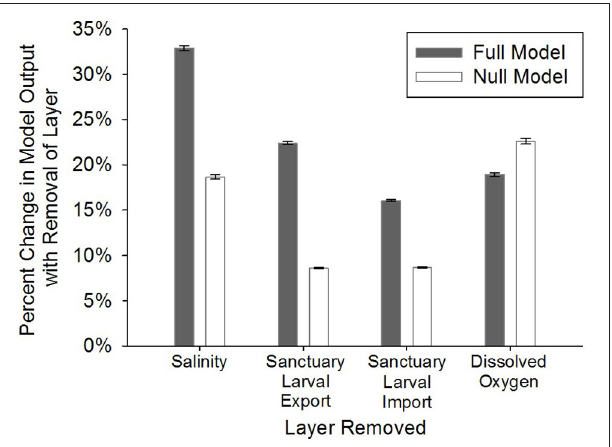
FIGURE 6 | Model validation. Relationship between habitat suitability index (HSI) at 10 existing oyster sanctuaries and normalized density. Normalized density is the product of mean 5-year oyster density and age of artificial reefs within each